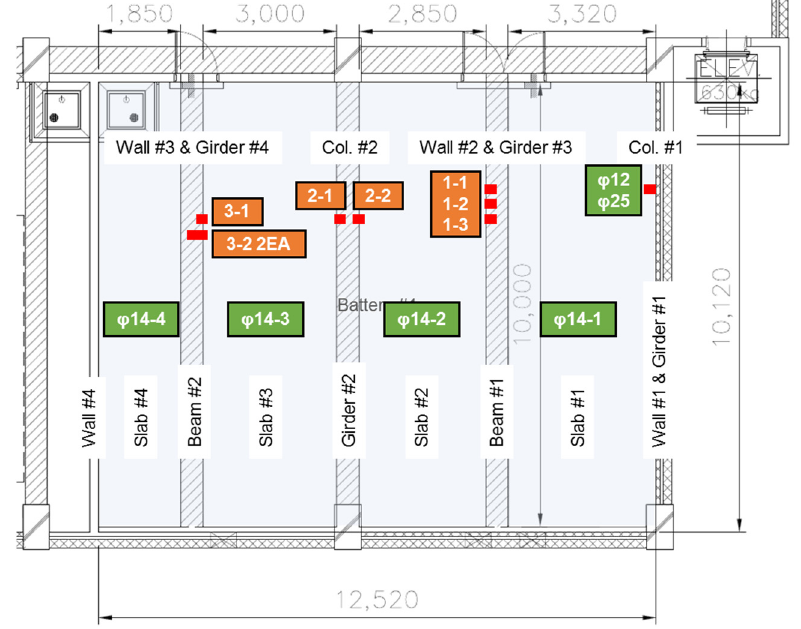
Figure 12. Locations of sampled concrete core and rebar coupons.